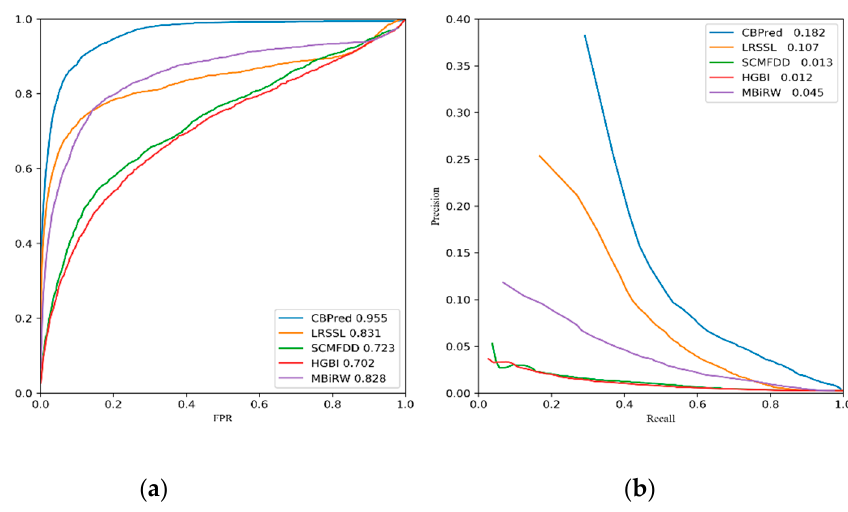
Figure 6. Two type of curves of CBPred and other methods for predicting performance evaluation. ( a ) Receiver operating feature characteristic (ROC) curves; ( b ) precision–recall (P–R) curves. Table 1. Prediction results of CBPred and four other methods for 15 drugs in terms of the area under the receiver operating characteristic curve (AUC).